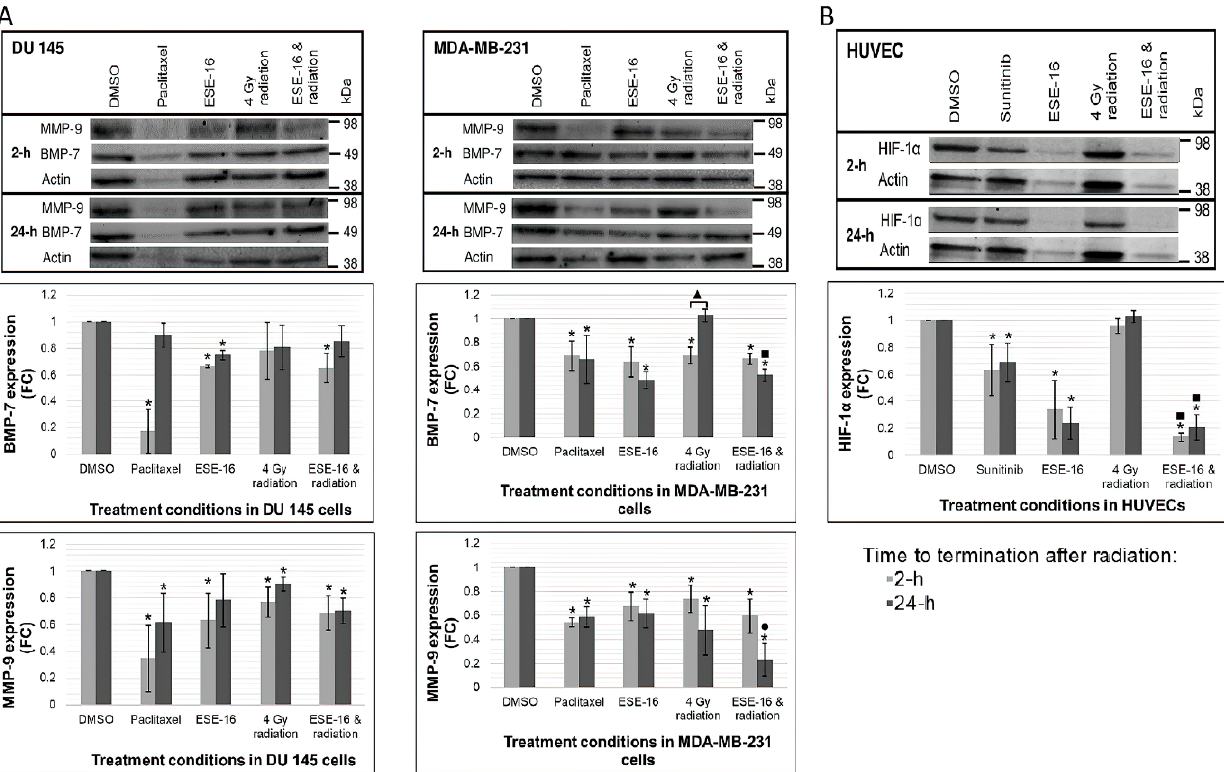
Figure 6. Western blot analyses of metastatic signaling proteins BMP-7 and MMP-9 in cancer cells ( A ), and pro-angiogenic signaling protein HIF-1 α in HUVECS ( B ) at 2 and 24 h post-treatment. DMSO was the vehicle control and served as a baseline. The positive method controls were paclitaxel (BMP-7 and MMP-9 inhibition) and sunitinib (HIF-1 α inhibition). Separate gels were used for each cell line and each time point and the relevant bands were identified against the protein standard molecular weights (MW). Membranes were cut to quantify the proteins of different MWs. BMP-7 (MW: 49 kDa) and MMP (MW: 92 kDa) expression decreased in DU 145 and MDA-MB-231 cells exposed to ESE-16 and radiation. MDA-MB-231 cells displayed delayed recovery of BMP-7 over 24 h when compared to the radiation control. Prominent reductions in HIF-1 α (MW: 93 kDa) expression were evident in HUVECs exposed to ESE-16 alone and the combination treatment. Actin (MW: 42 kDa) served as a housekeeping protein to which protein concentrations were standardized. Bar charts represent mean fold-change (FC) of three biological repeats with SD indicated by T-bars. Statistical significance ( p -value < 0.05) (cid:4) (cid:78) indicated by * when compared to DMSO, • when compared to ESE-16, and when compared to 4 Gy radiation and comparing 2- and 24